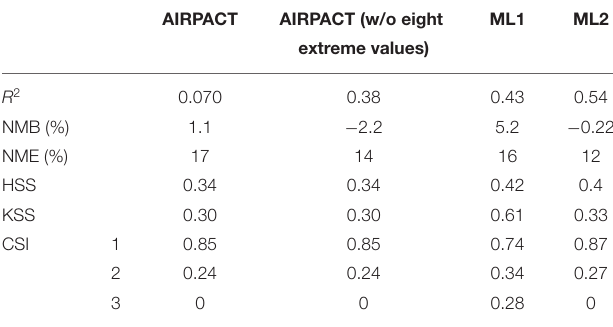
TABLE 4 | Statistics and forecast verifications of the 10-time, 10-fold cross-validations of the simulated O 3 at Kennewick, WA during